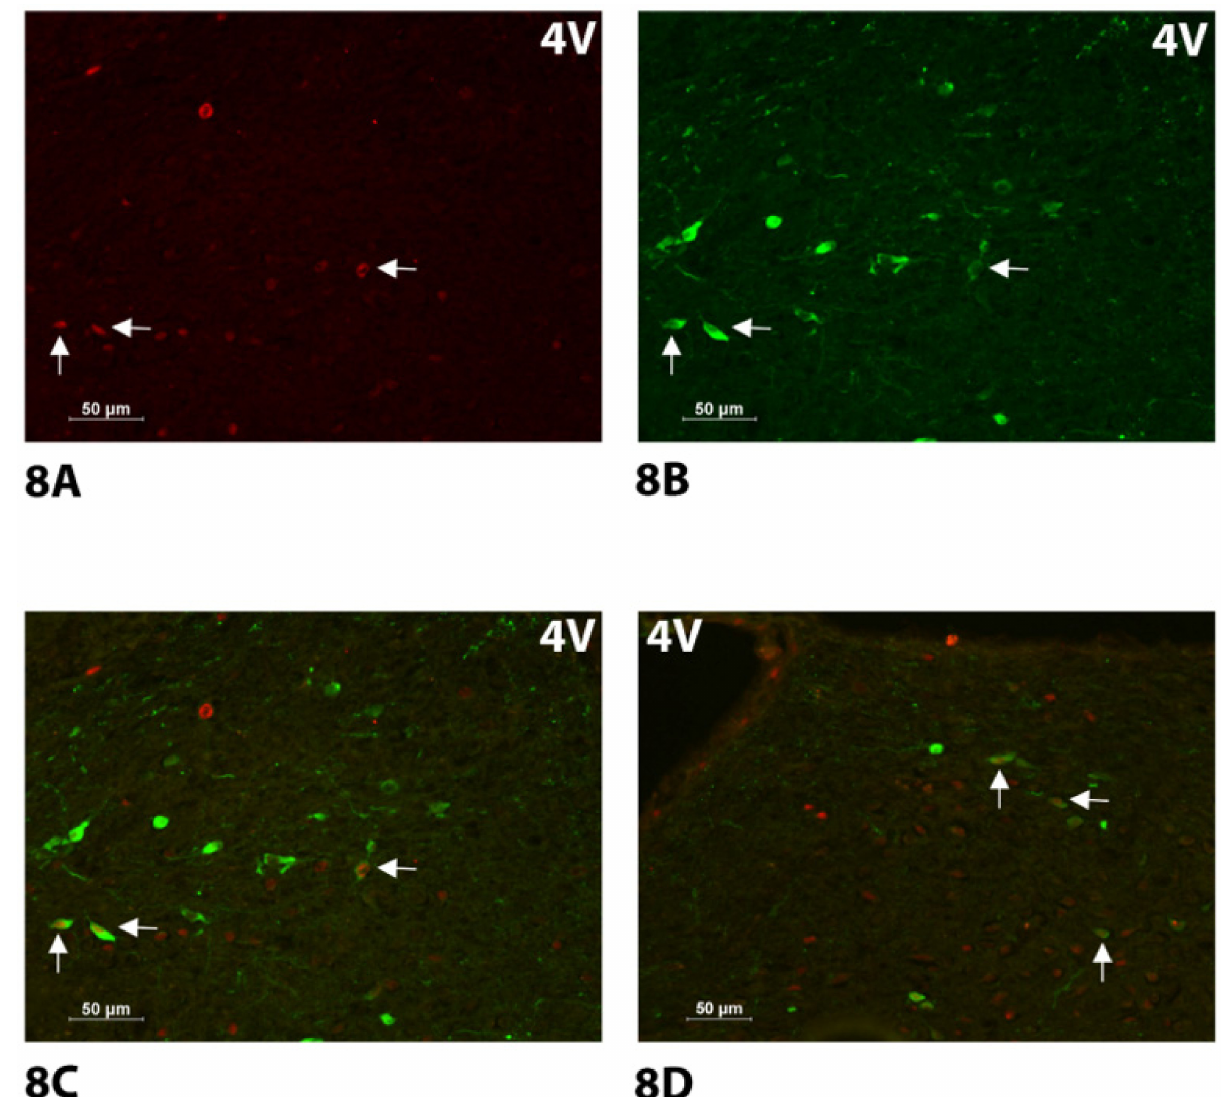
Figure 8. ( A – D ). Effect of acute 4V OT administration on Fos induction in cNTS catecholamine neurons using immunocy- tochemistry in male chow-fed SD-SAS rats. Neuronal activation is revealed by concentration of immunoreactive Fos in cell nuclei [Fos (+)] in the cNTS. Fos- and TH-immunostaining were done by Cy3 fluorescence and Alexa 488 fluorescence, respectively. Images were taken from one side of the cNTS. ( A ), Acute 4V administration of OT increased Fos (+) neurons in cNTS (see arrows). ( B ), TH staining in cNTS from an animal treated with 4V OT (see arrows). ( C ), Colocalization of TH (+) and Fos (+) neurons in cNTS from an animal treated with 4V OT (see arrows). ( D ), Colocalization of TH (+) neurons and Fos (+) neurons in the cNTS from the opposite side (see arrows) ((Bregma − 13.44; [43]) same animal as in ( A – C )); ( A – D ) all visualized at 20 ×